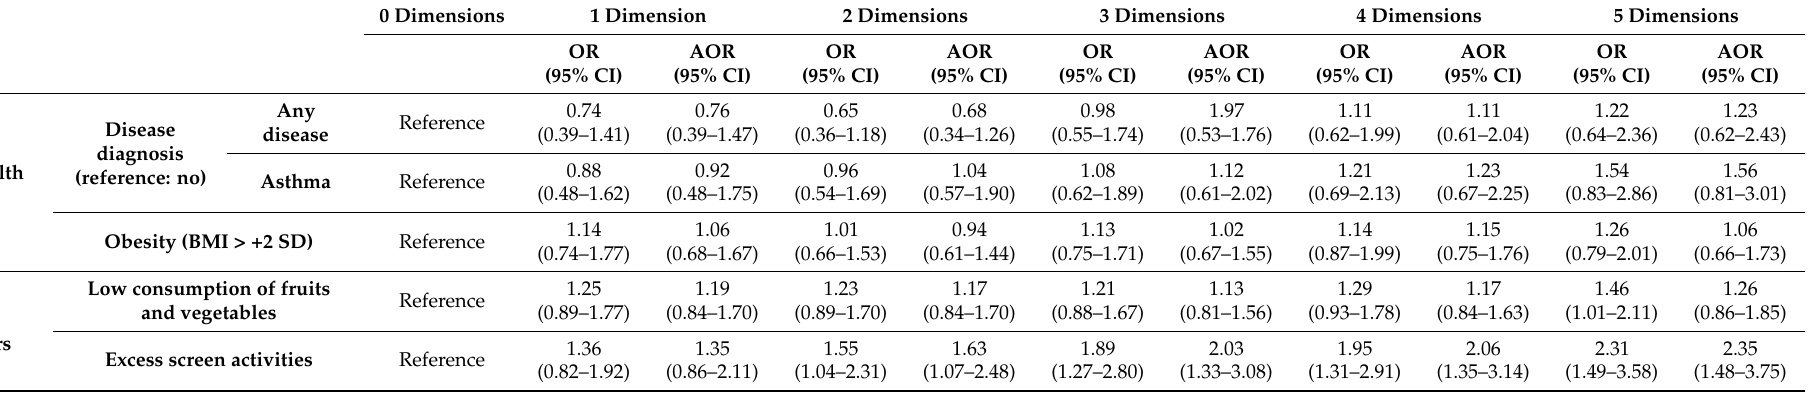
Table 4. Associations (Odds Ratio and 95% Confidence Interval, OR (95%CI)) of child health status and behaviors with the sum of the dimensions of adverse childhood experiences (ACEs) in the Generation XXI ( n =